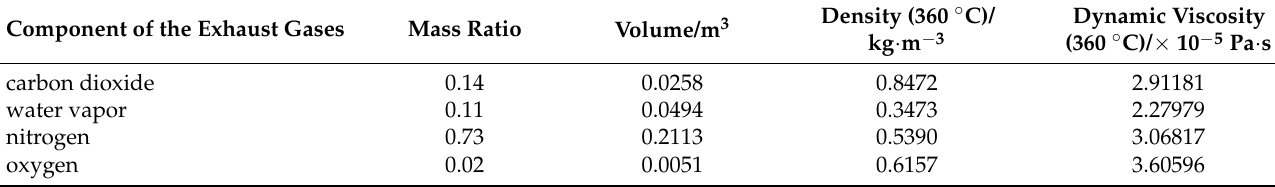
Table 2. The mass ratio, volume, density and dynamic